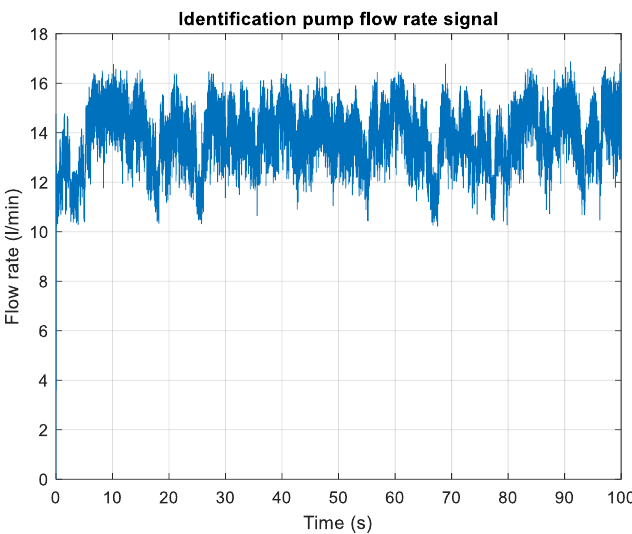
Figure 7. Pump pressure signal used for identification experiment. Figure 8. Hankel singular values of estimated models.